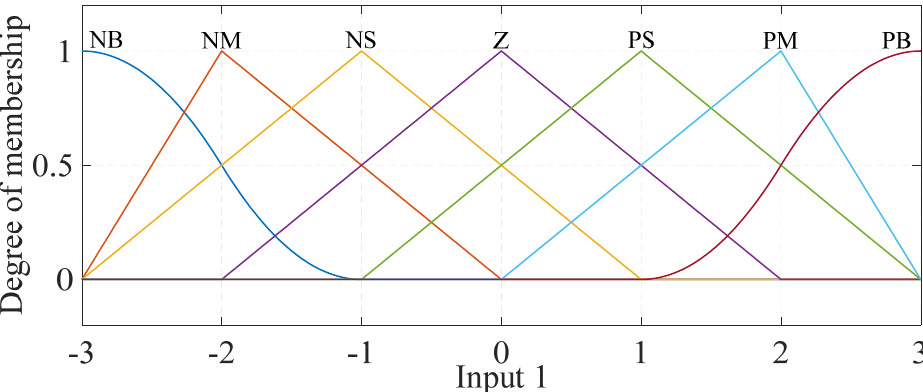
Figure 5. Membership functions for input 1 (the generator speed sensor). Table 3. Membership function, fuzzy set labels, and fuzzy numbers representation for Figure 5.